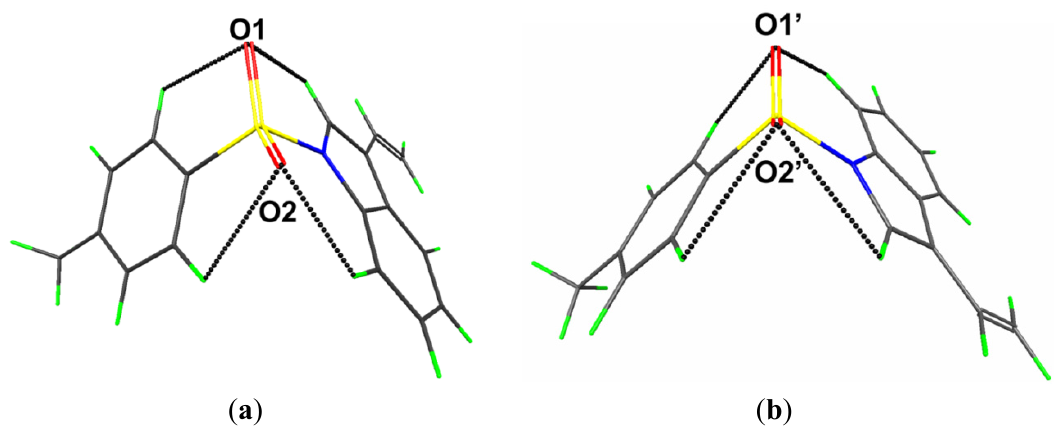
Figure 7. Geometry optimised molecules for the ( a ) S1- and ( b ) S1'-containing molecules of ( 2 ). Details of the intramolecular C-H···O interactions are tabulated in Table 2.